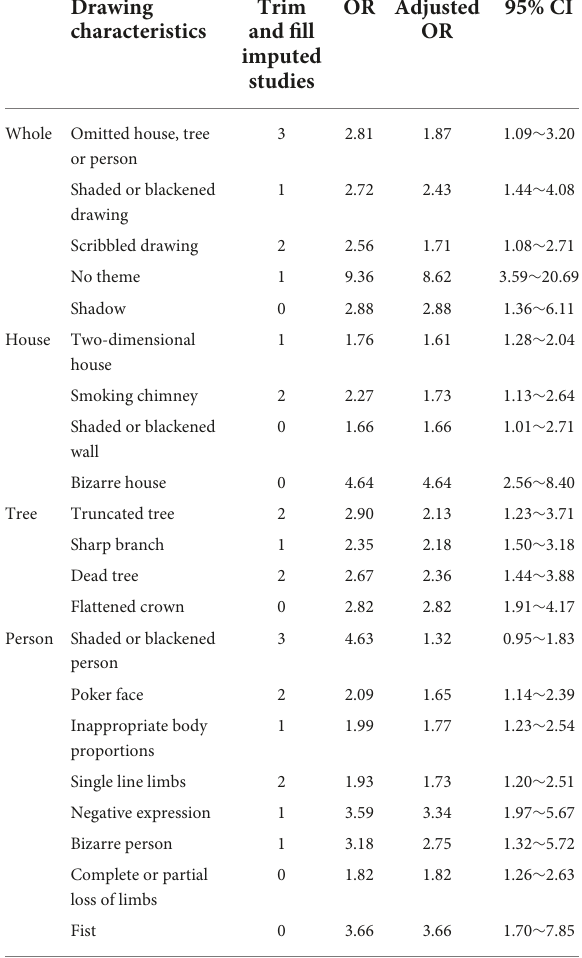
TABLE 4 Analysis of publication bias.